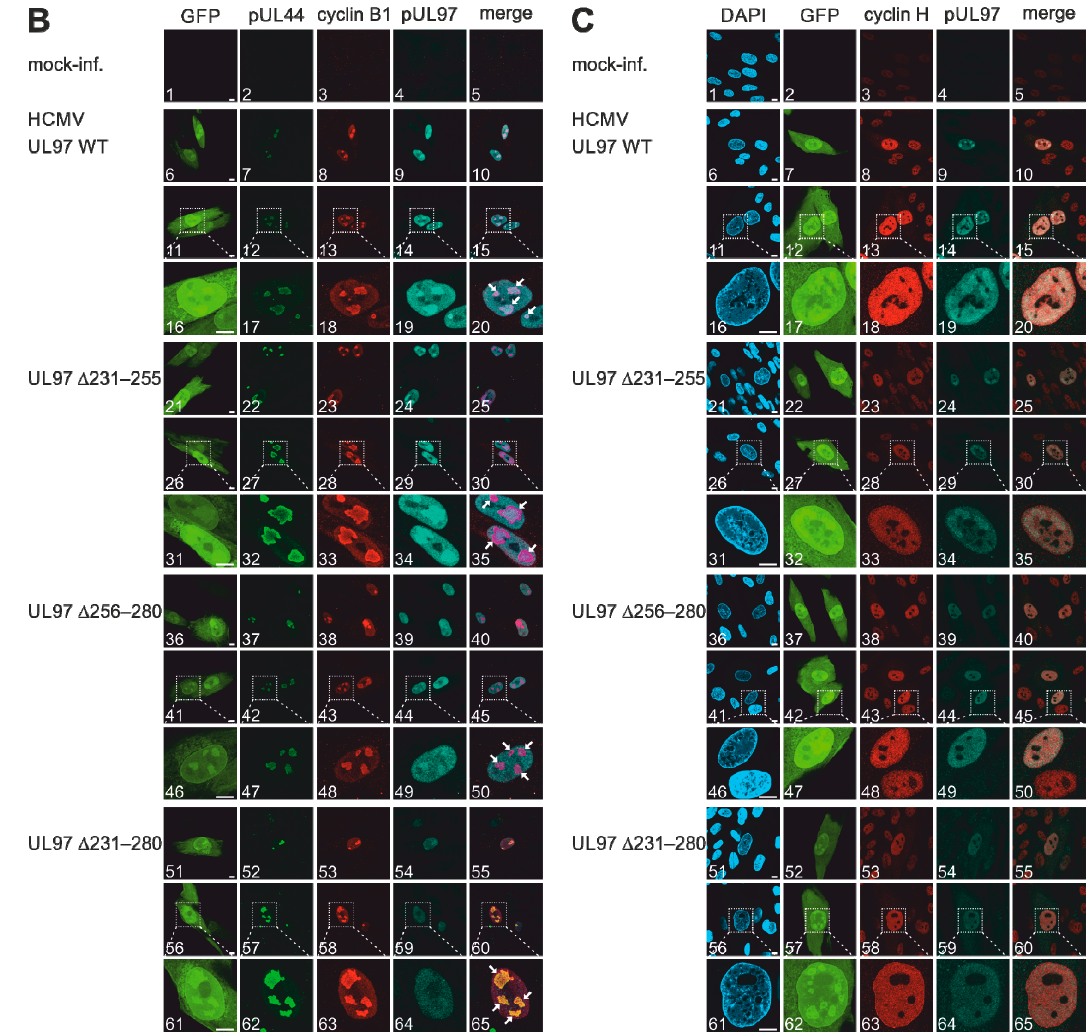
Figure 5. Confocal imaging analysis of the localization of human cyclins and UL97 mutants in HCMV-infected HFFs. HFFs were infected with WT and recombinant HCMVs at an MOI of 0.1 and harvested at 3 d.p.i. (marked by the GFP reporter expression of the recombinant viruses). Indirect immunofluorescence staining was performed with antibodies against pUL97 and human cyclins T1 ( A ), cyclin H ( B ) and cyclin B1 ( C ) and representative panels of confocal imaging are given. Regarding cyclin T1 ( A ) and H ( C ) stainings, secondary Abs anti-rabbit Alexa 555 was used to visualize human cyclins and anti-mouse Alexa 647 to visualize pUL97. Concerning cyclin B1 ( B ), pUL44 was stained to depict viral replication centers (marked by white arrows). pUL44 was visualized using anti-mouse Alexa 350, cyclin B1 by using anti-goat Alexa 555 and pUL97 by using anti-rabbit Alexa 647. Scale bar, 10 μ m. Table 1. Colocalization of cyclins in viral nuclear replication centers